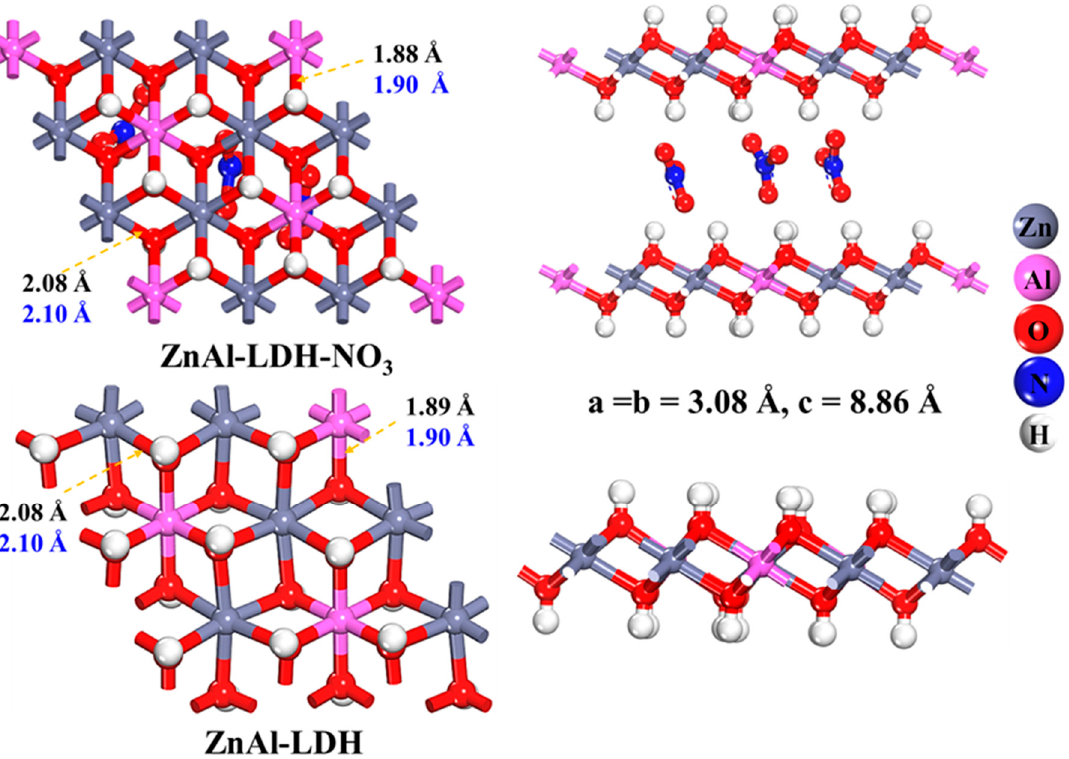
Figure 1. Geometric structures of ZnAl-LDH-NO 3 and ZnAl-LDH optimized by the PBE + vdW method together with experimental values [31] in blue.